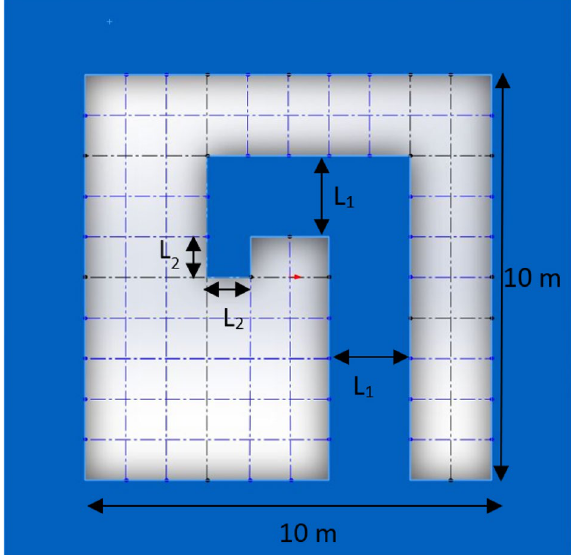
Figure 1. The Geometry of the room. The room is divided to 77 cells with 100 × 100 cm dimensions. The center of each cell is considered for the position of the gamma source. For studying the effect of wall thickness, three cases are considered for L 1 and L 2 : (L 1 = 50 cm, L2 = 50 cm), (L 1 = 100 cm, L 2 = 100 cm) and (L 1 = 200 cm, L 2 = 100